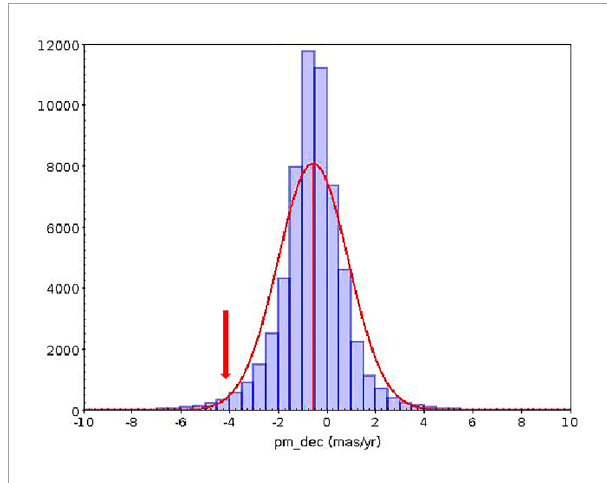
FIGURE A10 Histogram of the distribution in μ δ (in mas yr −1 ) of the stars within 1 degree of the geometrical center of Tycho’s SNR in the range of distance compatible with SN 1572 (1.7 < d < 3.7 kpc). The data are obtained from Gaia DR2 . The red vertical line shows the μ δ of star G.